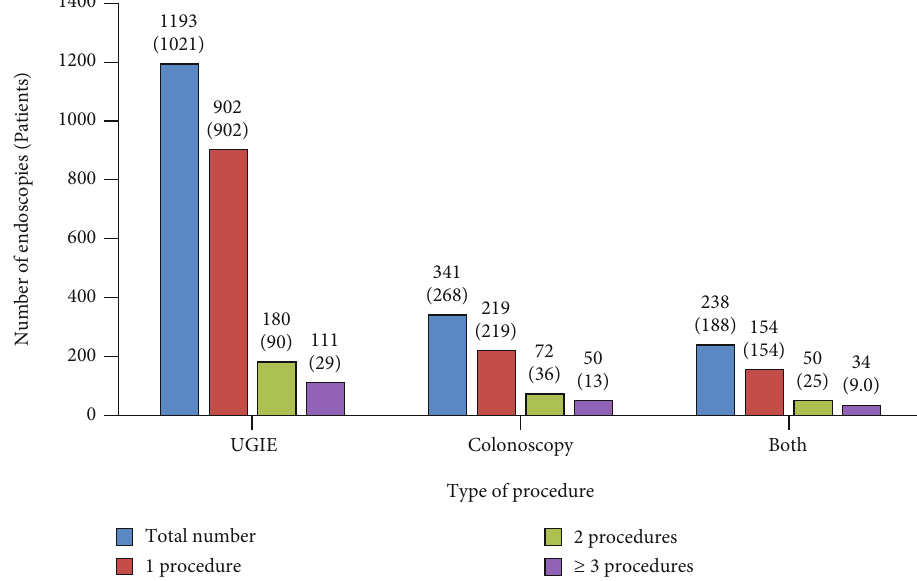
Figure 2: Number of pediatric gastrointestinal endoscopic procedures ( n = 1534 ) per patient ( n = 1101 ). UGIE: upper gastrointestinal